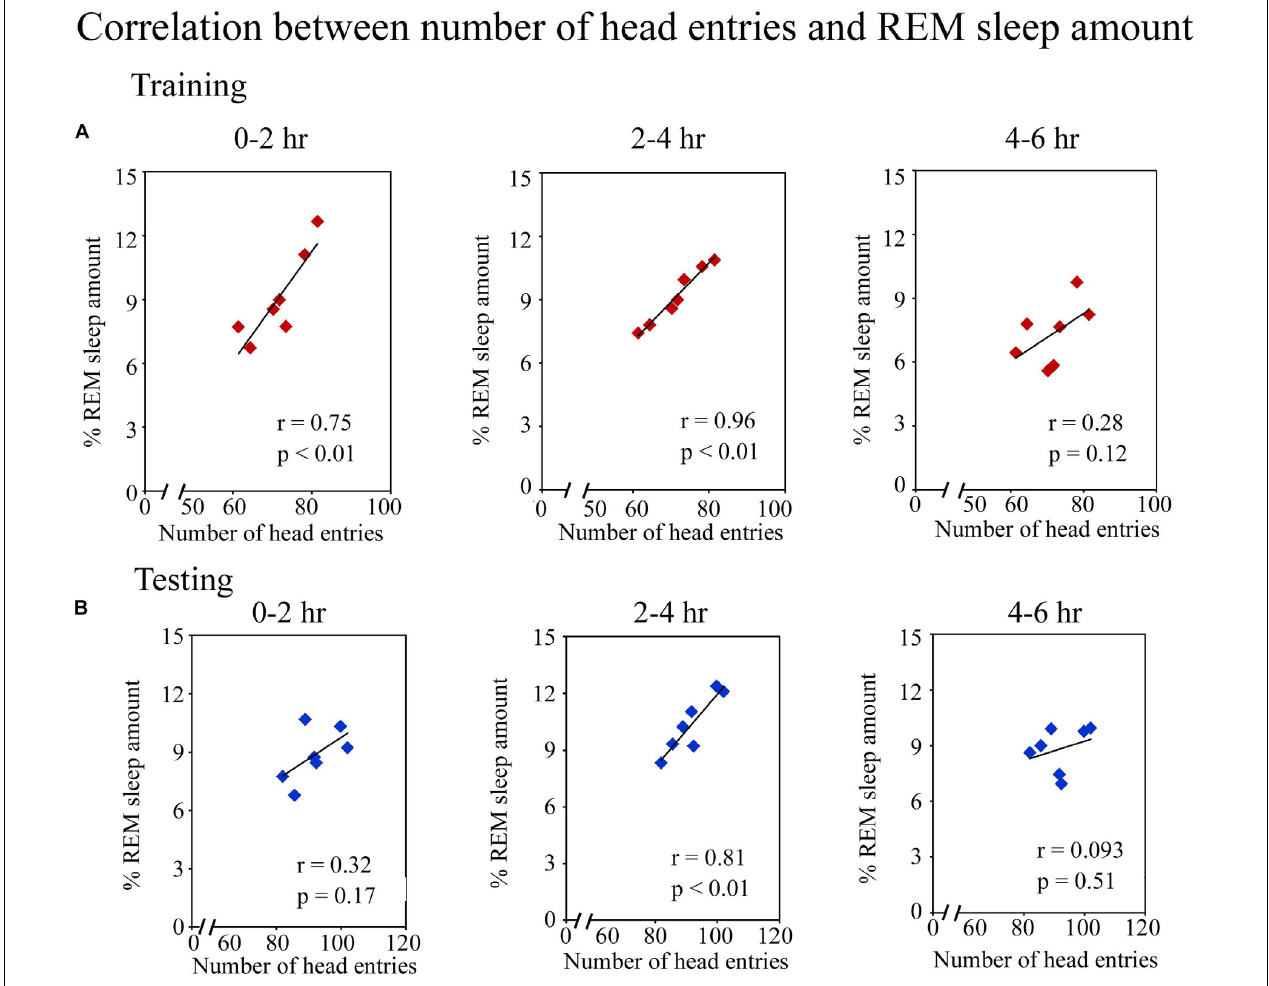
FIGURE 4 | Pearson correlation between performance and percent REM sleep amount. (A) The number of head entries significantly positively correlated with the REM sleep amount at 0–2 h ( r = 0.75; p < 0.01) and 2–4 h ( r = 0.96; p < 0.01) periods on the training day. (B) It also significantly correlated on the testing day, but only during the 2–4 h ( r = 0.81; p < 0.01)